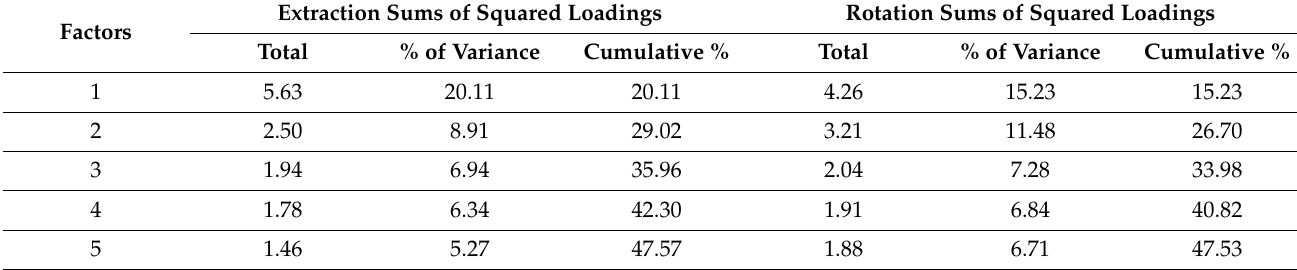
Table 2. Total variance explained.